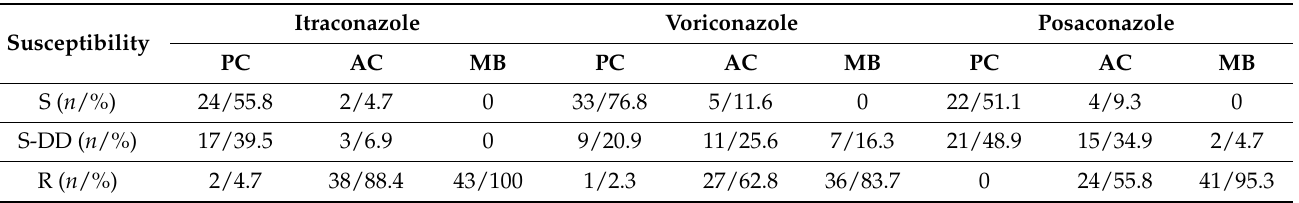
Table 4. Evaluation of susceptibility of planktonic cells (PC), adhered cells (AC) and mature biofilm (MB) of M. pachydermatis strains to tested antimycotics.